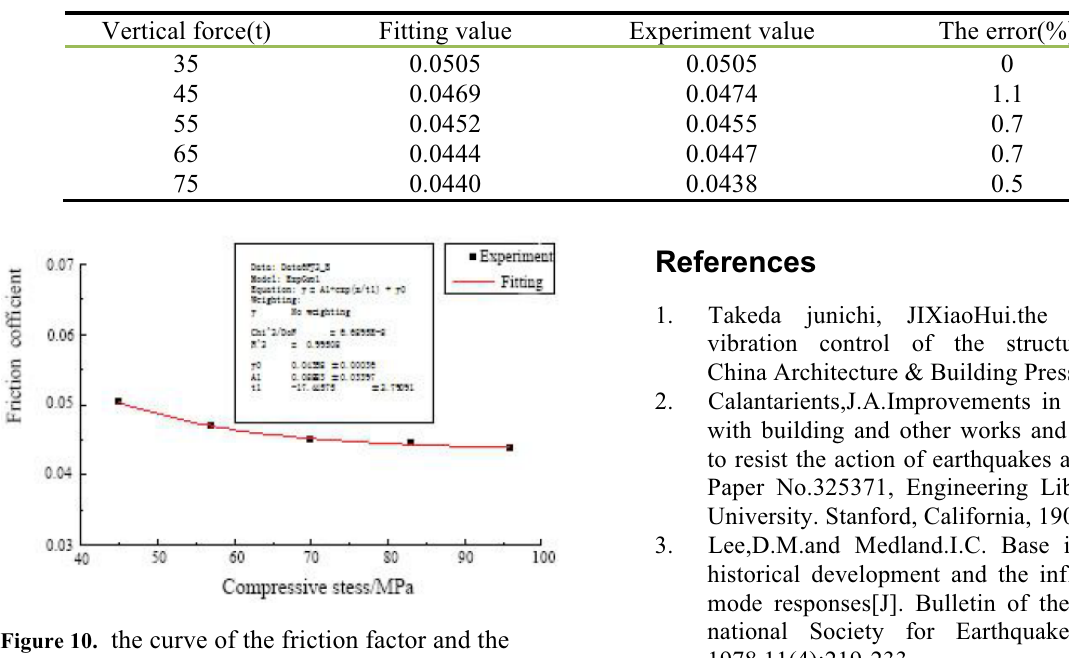
Table.2 The contrast of the friction factor’s fitting value and the experiment value